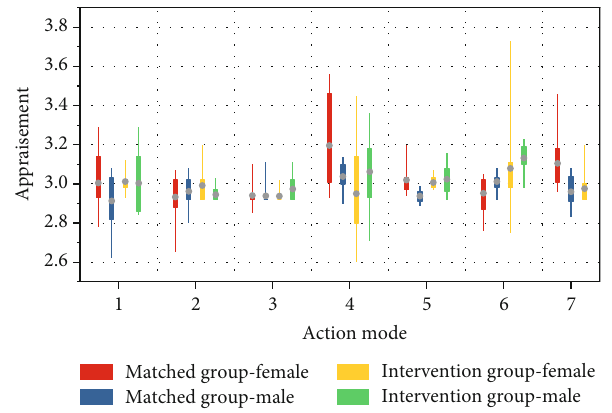
Figure 8: 12 weeks of intervention training in two groups of di ff erent gender test results.